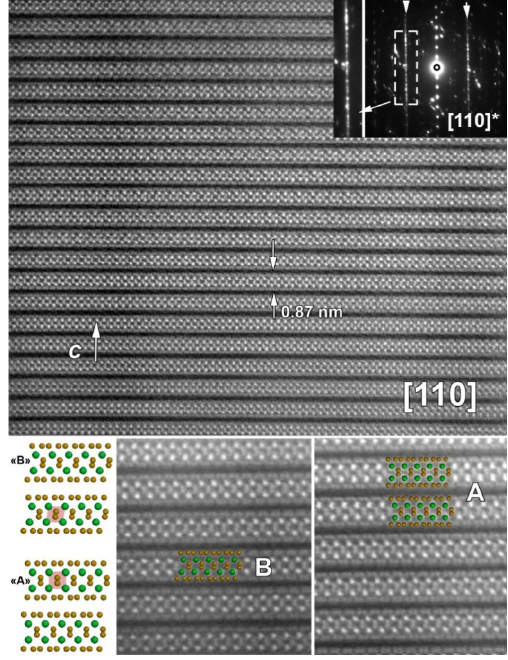
Figure 3. High-resolution ( 110 ) high angular annular dark field scanning transmission electron microscopy (HAADF-STEM) image of Ti 0.93 Nb 0.07 S 3 sample and corresponding electron diffraction (ED) pattern. On bottom left panel two possible structure models, B and A variants are viewed along ( 110 ) zone axis (Ti/Nb—Green, S—Yellow). Bottom center and right panels show enlargement HAADF-STEM image together with overlays B and A variants respectively, evidencing the mixture of both variants at nanoscale within single